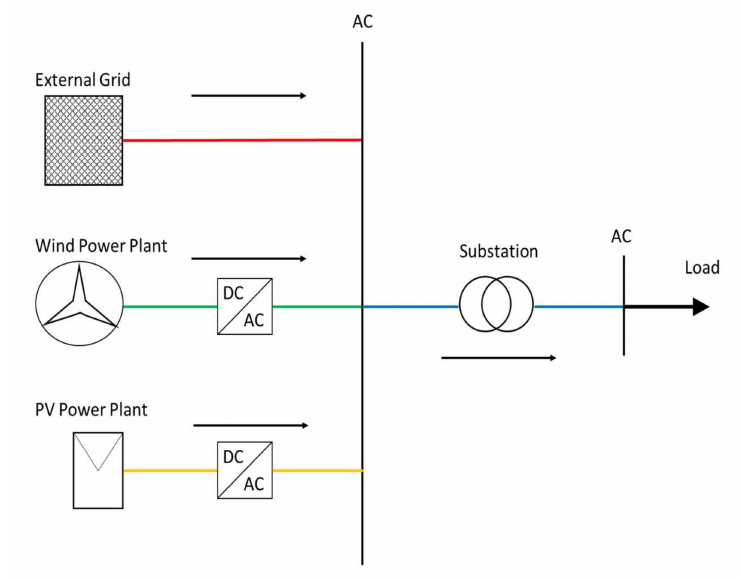
Figure 3. Proposed energy system